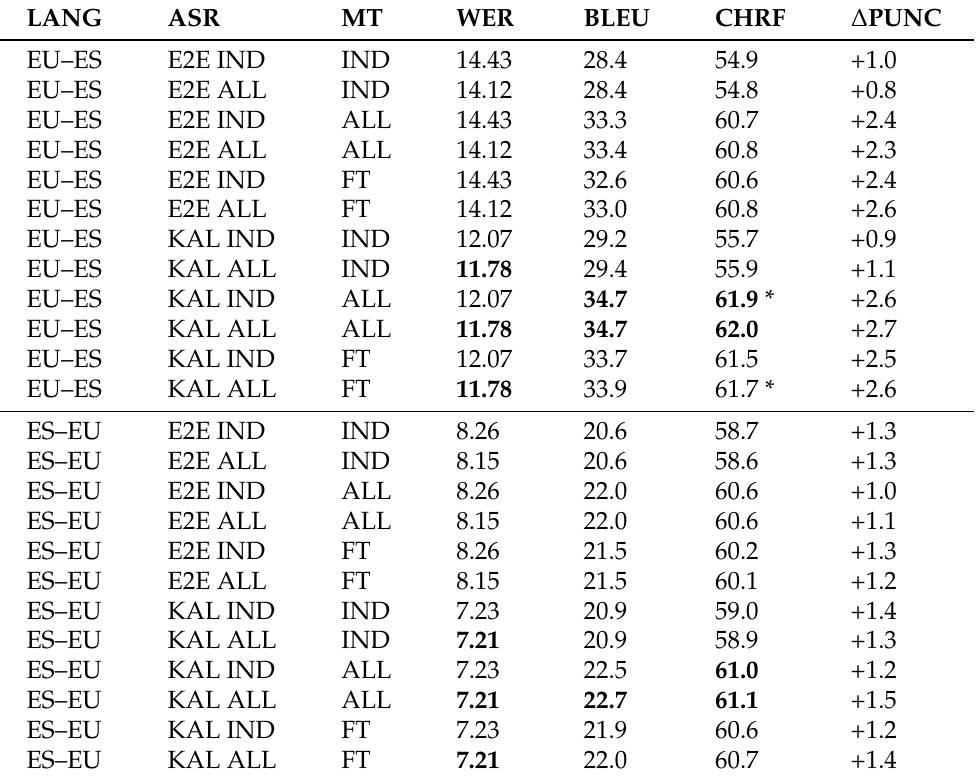
Table 8. Evaluation results on cascade variants. The best results, indicated in bold, are statistically significant against all other results, for p < 0.05, except where indicated as *; differences between top-performing systems in bold were not statistically significant.